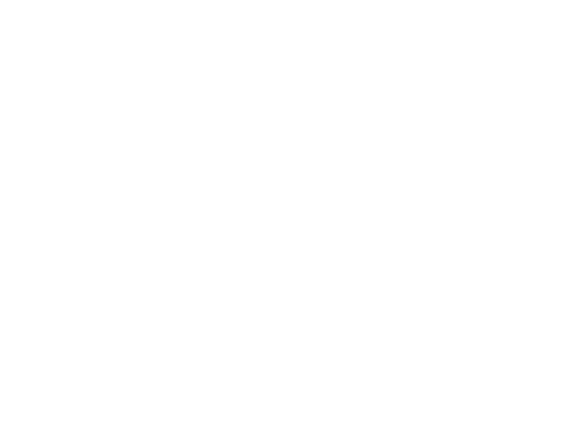
Figure 5. Effects of platelet-derived mEVs on the expression of gene markers of EMT in cocultures with the human colorectal carcinoma cell line HCT116. Cancer cells (0.5 × 10 6 ) were incubated for 4 or 24 h with CRC or HS EVs (100 µ g), and gene expression of TWIST1 ( A ), CDH1 (protein name E-cadherin) ( B ), and VIM (protein name vimentin) ( C ) was evaluated by qPCR and normalized to those of GAPDH and reported as fold-change vs. the gene expression detected in the cocultures of mEV from HS with the cancer cells. The values were not normally distributed and were transformed to logarithms, and all values are shown as scatter dot plots with mean + SD, n = 10, and analyzed by one-way ANOVA followed by Tukey’s multiple comparisons test. ( A ) TWIST , 24 h, * p < 0.05 vs. vehicle; ( B ) CDH1 4 h, ** p < 0.01 vs. vehicle and EV HS, 24 h, § p < 0.01 vs. vehicle and EC HS; ( C ) VIM , 4 h, * p < 0.05 vs. vehicle, ** p < 0.01 vs. vehicle, 24 h, § p < 0.01 vs. vehicle and EV HS.